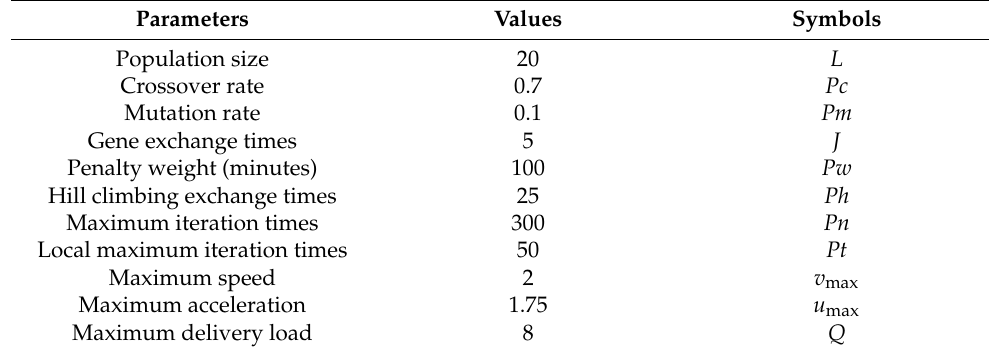
Table 3. Related parameters of the indoor route planning algorithm.